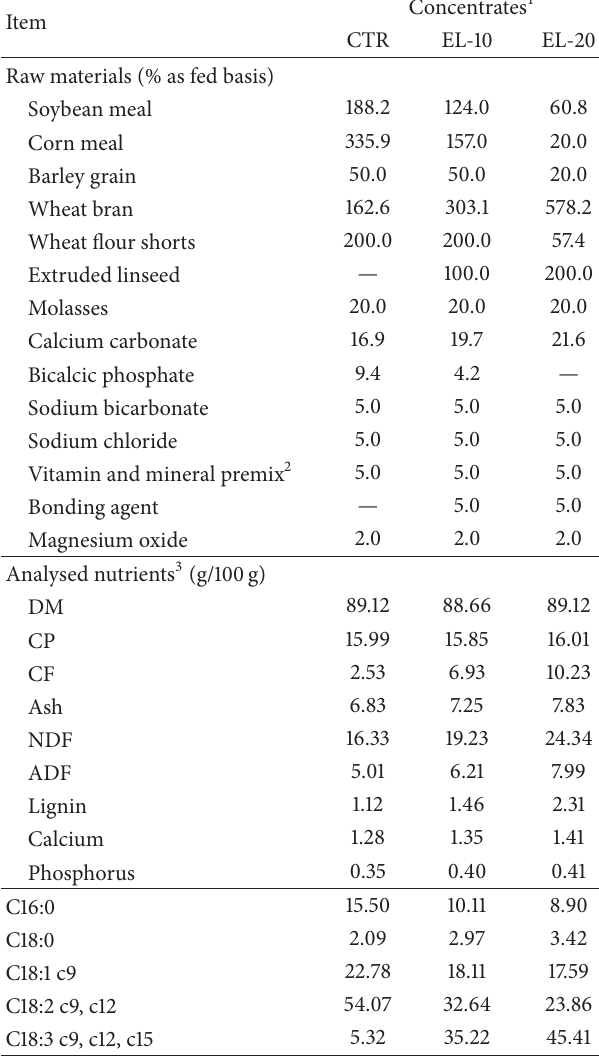
Table 1: Ingredients and chemical composition of the experimental concentrates fed during the